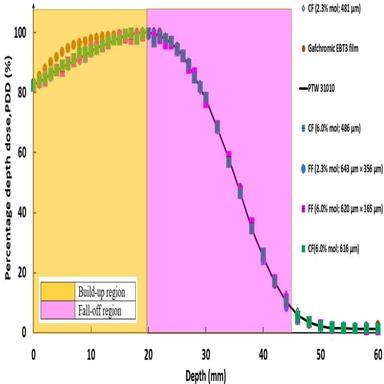
PDD of PTW 31010 IC, all fabricated fibres & Gafchromic™ EBT3 film at different depths.